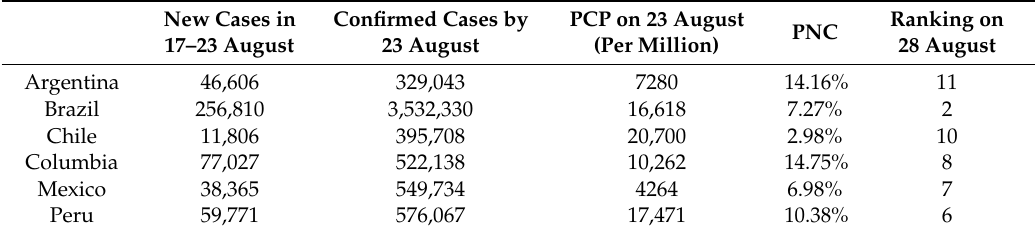
Table 1. The epidemiological data of some Latin American countries with the most confirmed cases in the